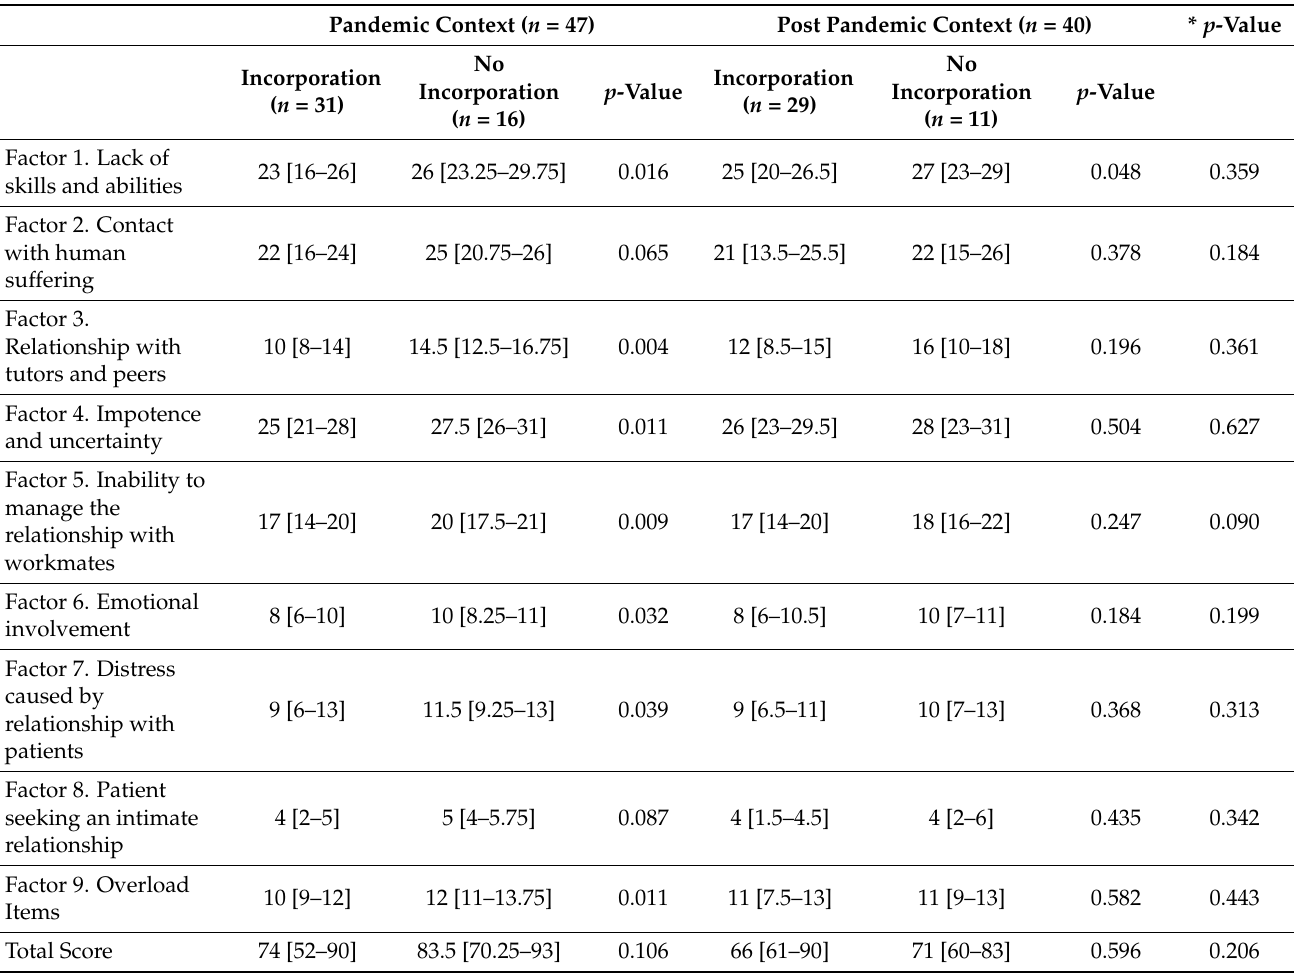
Table 2. Differences between the stressors expressed by the students who were incorporated or not into the workforce during the pandemic context and post-pandemic